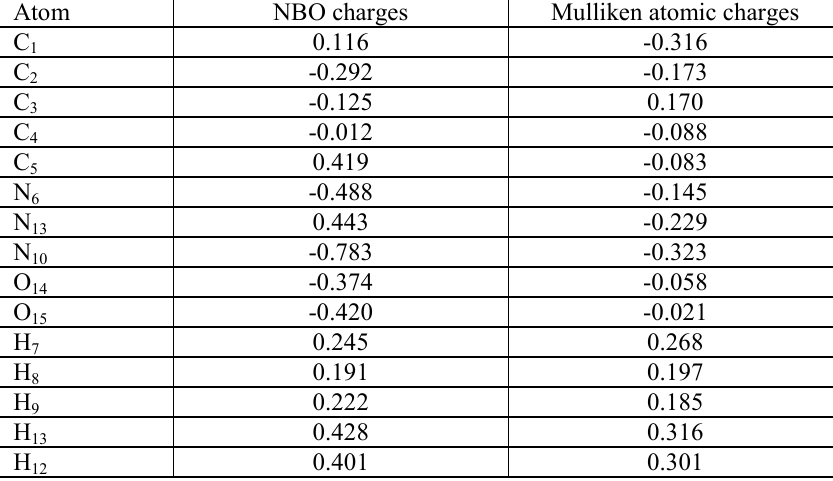
Table 2 . Natural atomic charges (e) of ANP calculated at B3LYP/6-31++G(d, p) level of the theory and basis